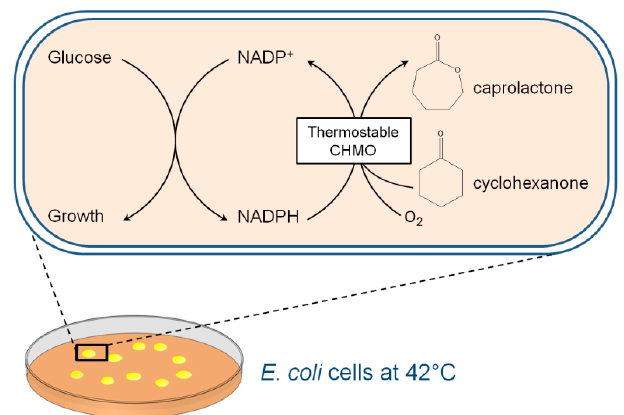
Figure 1. A redox balance-based selection platform at a high temperature. Growth restoration of